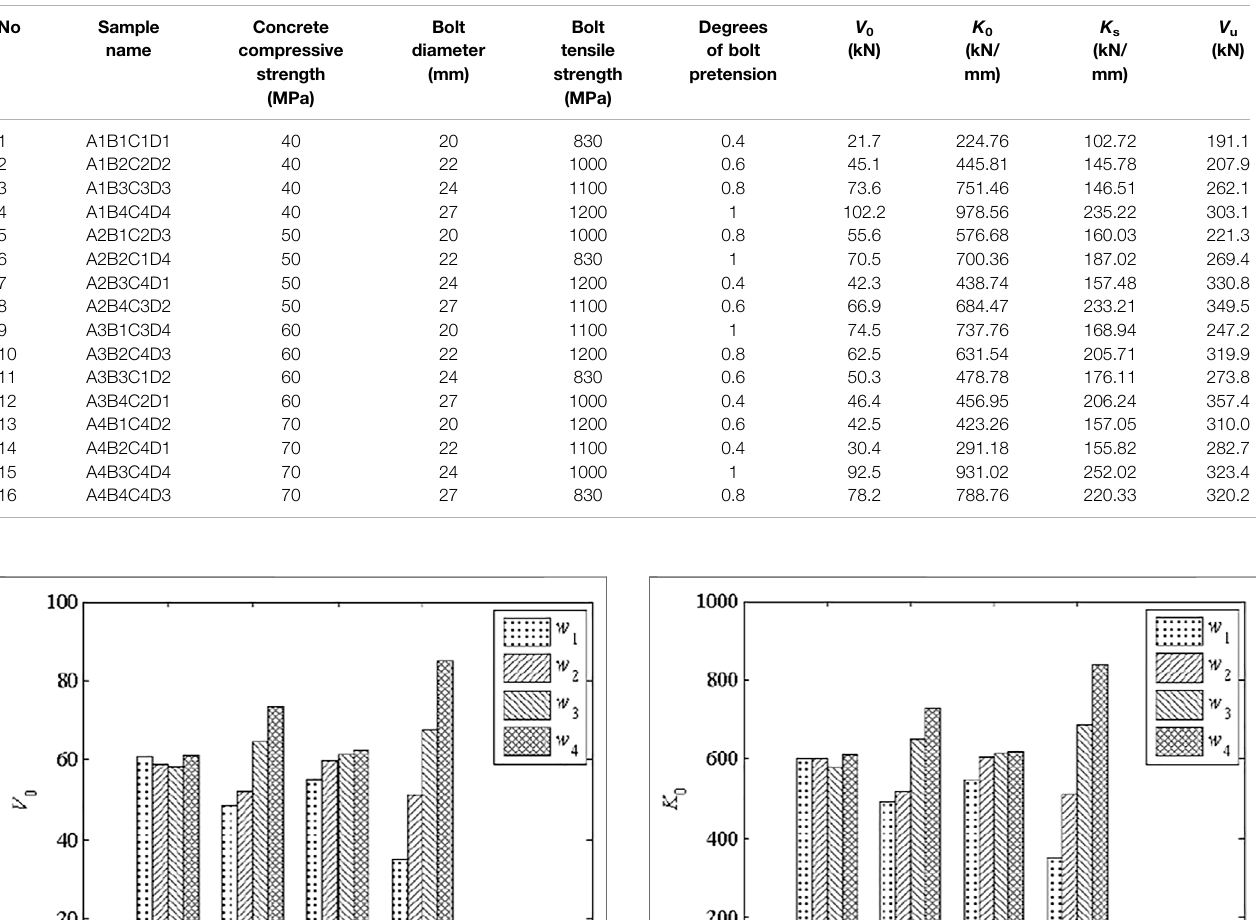
TABLE 2 | The summary of numerical samples and results.